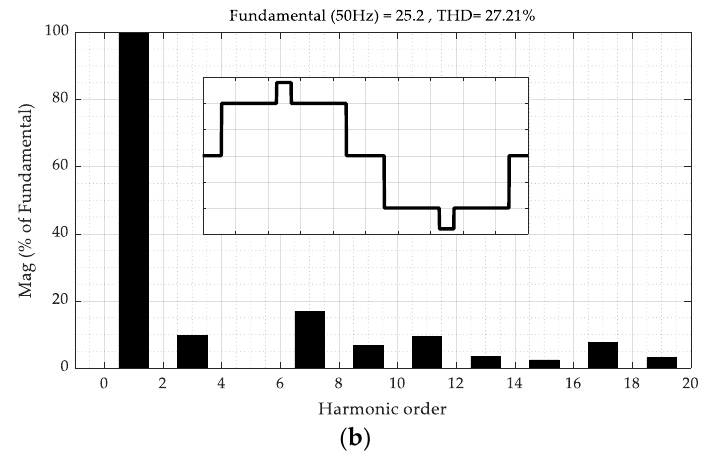
Figure 11. Change in the output voltage waveform due to α 2 when x = 0.4 (V 2 = 8 V, V 1 = 20 V) and h 5 is removed: ( a ) MI = 0.85 and ( b ) MI = 0.9.